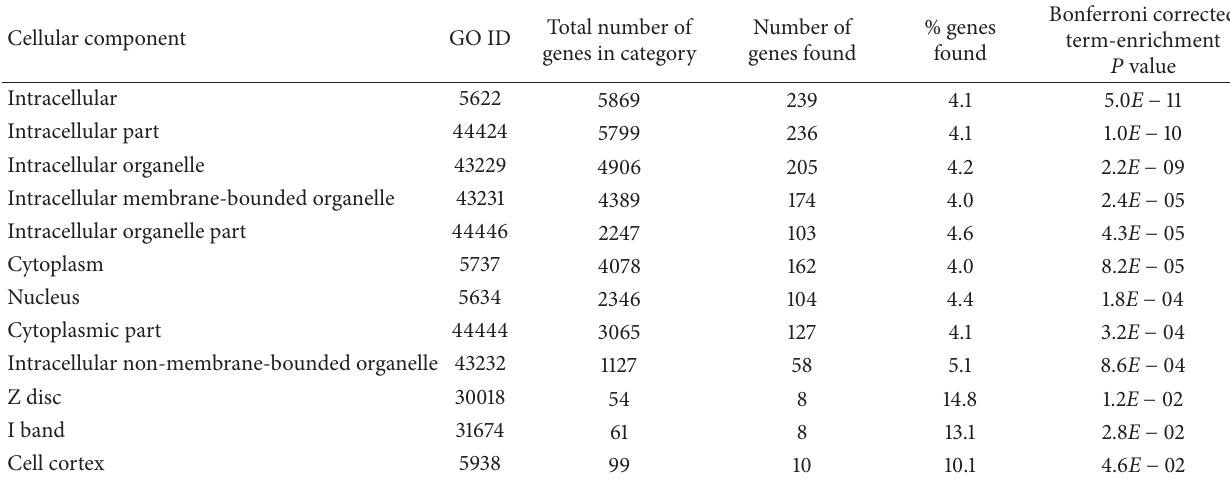
Table 3: Gene ontology analysis of transcripts regulated in total DCs from lung-draining lymph nodes. Cellular